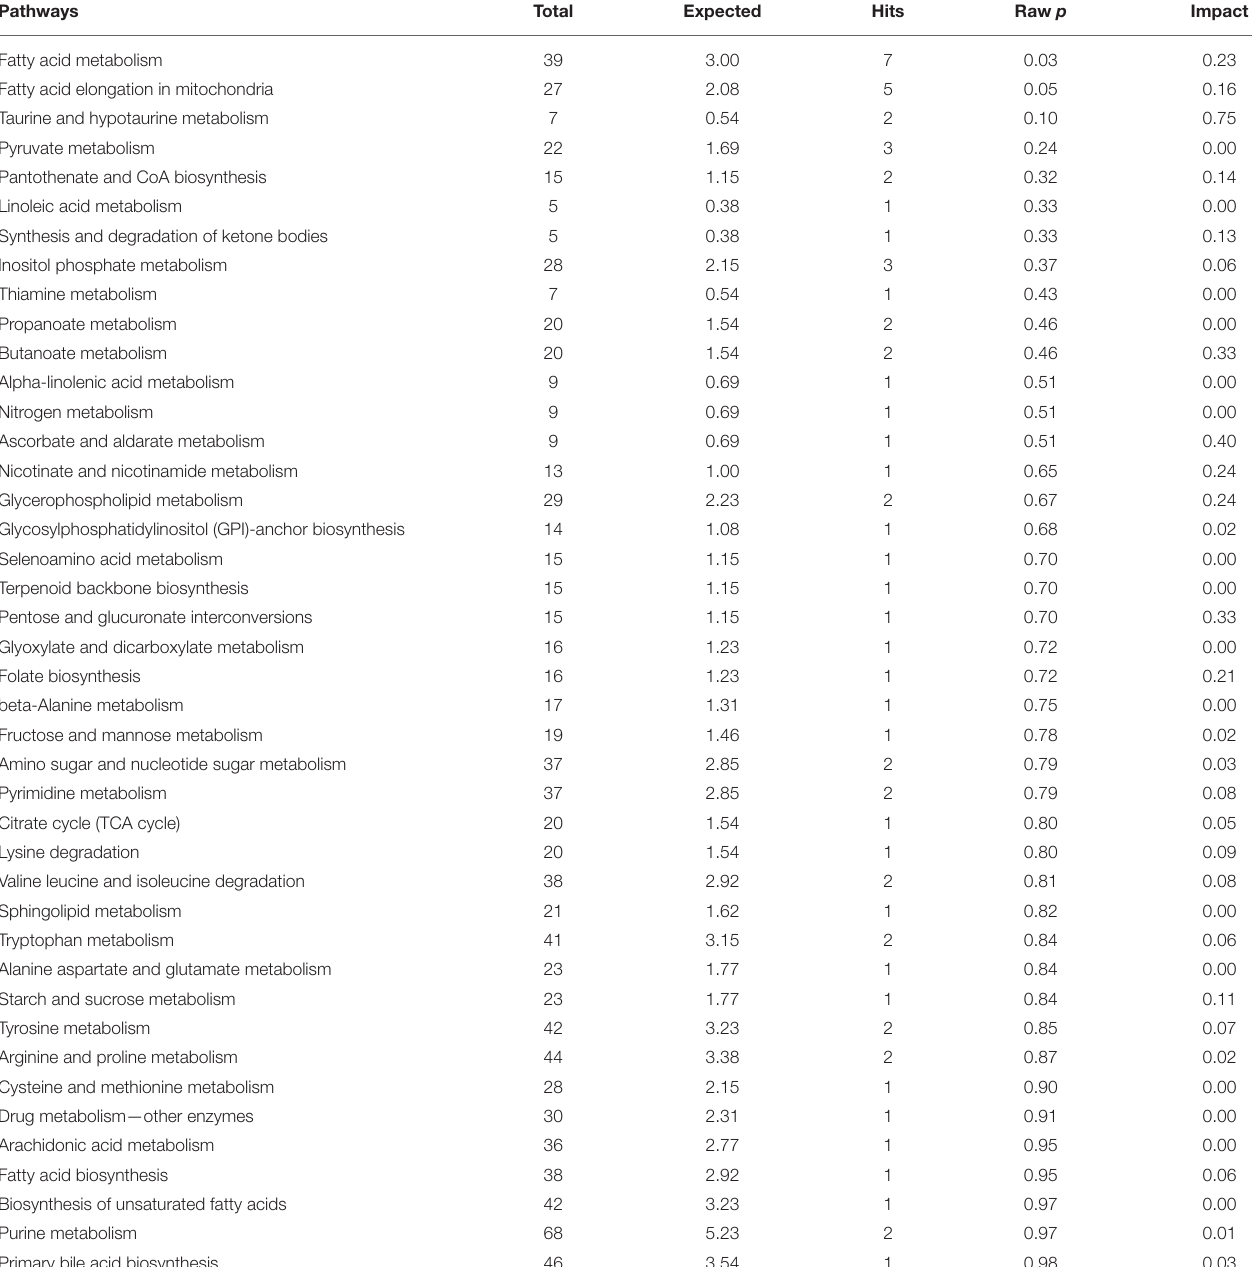
TABLE 1 | Enrichment of pathways involved in unique metabolites of spermatozoa in normozoospermia bulls. Pathways Total Expected Hits Raw